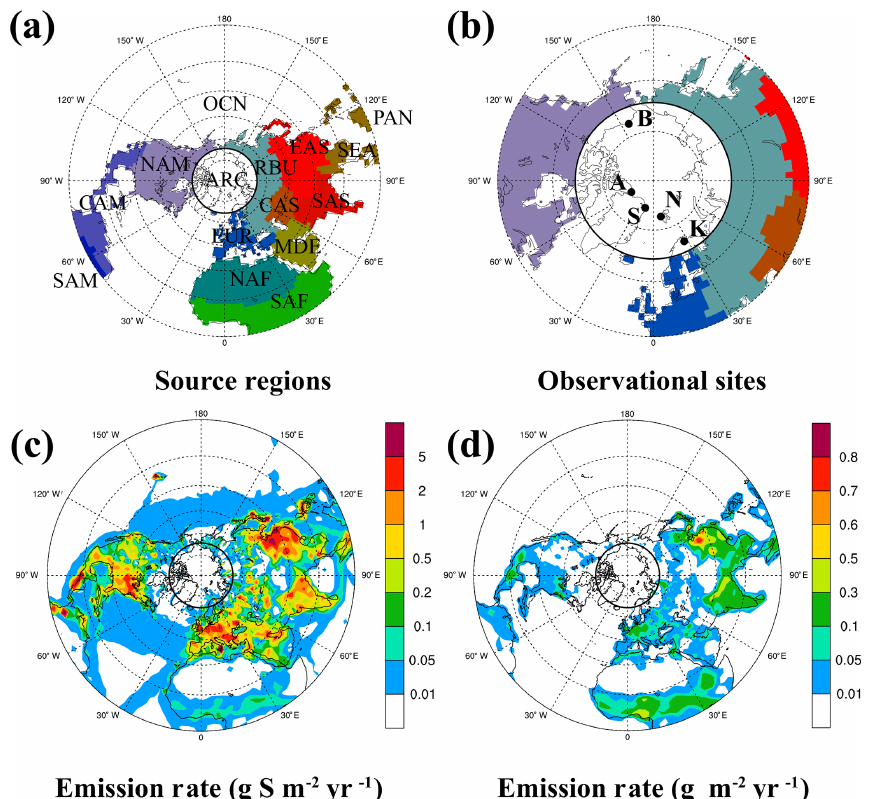
Figure 1. (a) The 16 anthropogenic source regions – Europe (EUR), North America (NAM), Central America (CAM), South America (SAM), northern Africa (NAF), southern Africa (SAF), the Middle East (MDE), Southeast Asia (SEA), Central Asia (CAS), South Asia (SAS), East Asia (EAS), Russia–Belarus–Ukraine (RBU), Pacific–Australia–New Zealand (PAN), the Arctic (ARC), Antarctic (ANT), and non-Arctic and non-Antarctic oceans (OCN). Dots in (b) mark observational sites at Alert (A; 82 ◦ N, 62 ◦ W), Station Nord (S; 81 ◦ N, 16 ◦ W), Barrow (B; 71 ◦ N, 156 ◦ W), Ny-Ålesund (N; 78 ◦ N, 11 ◦ E) and Kevo (K; 69 ◦ N, 27 ◦ E). Spatial distribution of annual mean (c) SO 2 (gSm − 2 yr − 1 ) and (d) BC (gCm − 2 yr − 1 ) emissions averaged over 1980–2018. The thick black circles mark the Arctic (66.5–90 ◦